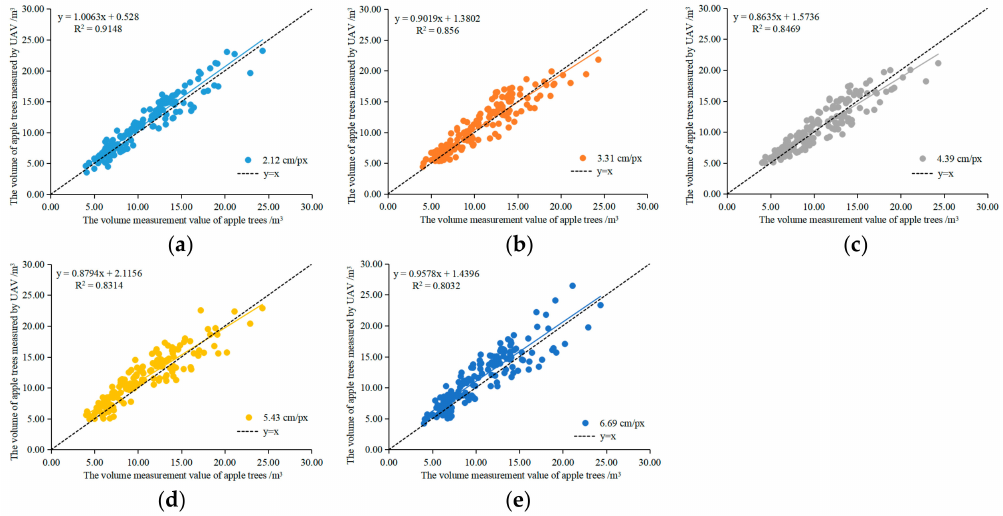
Figure 10. Canopy volume values measured manually and estimated by UAV. ( a ) GSD = 2.12 cm / px; ( b ) GSD = 3.31 cm / px; ( c ) GSD = 4.39 cm / px; ( d ) GSD = 5.43 cm / px; ( e ) GSD = 6.69 cm /